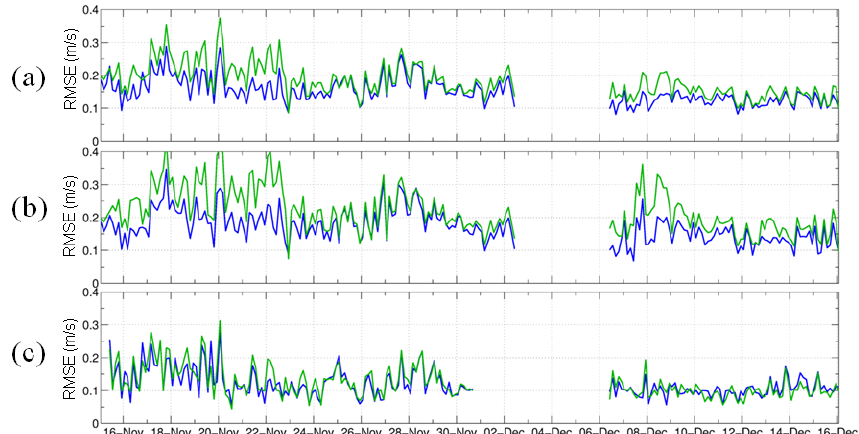
Figure 8. (a) Er time evolution of radial velocity from (a) both radar sites ( y ), (b) PEY ( y pey ) and (c) BEN ( y ben ) for WindReal . Er b (Er a ) is in green (blue).